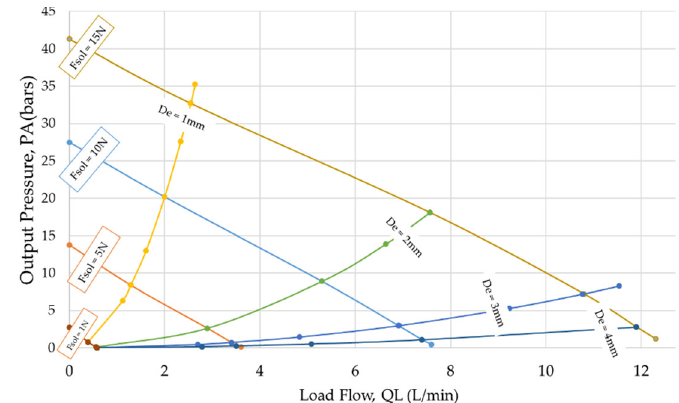
Figure 9. Summary of steady-state results.